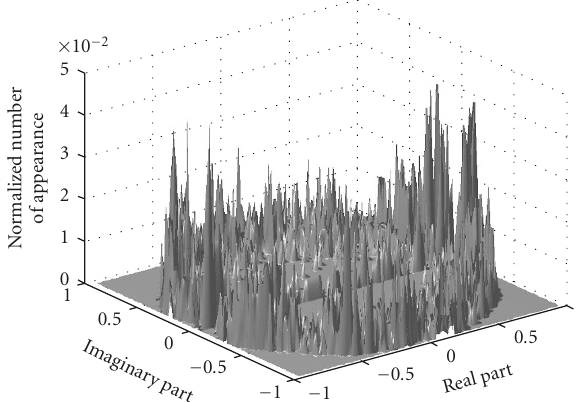
Figure 11: Histogram showing the number of poles of the speech production system in each small region in the complex